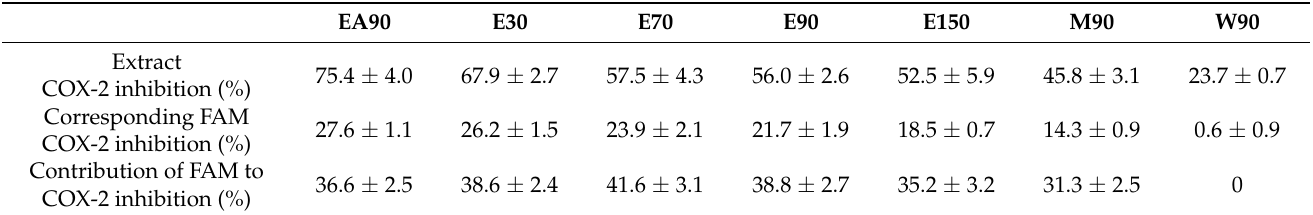
Table 3. Relative COX-2 inhibition to control (%) of Waltheria indica extract solution (20 µ g/mL) and fatty acid mixture solution (20 µ g/mL) with 0.5 µ M celecoxib as control set to 100%. Data points represent the mean value ± standard deviations of six samples.